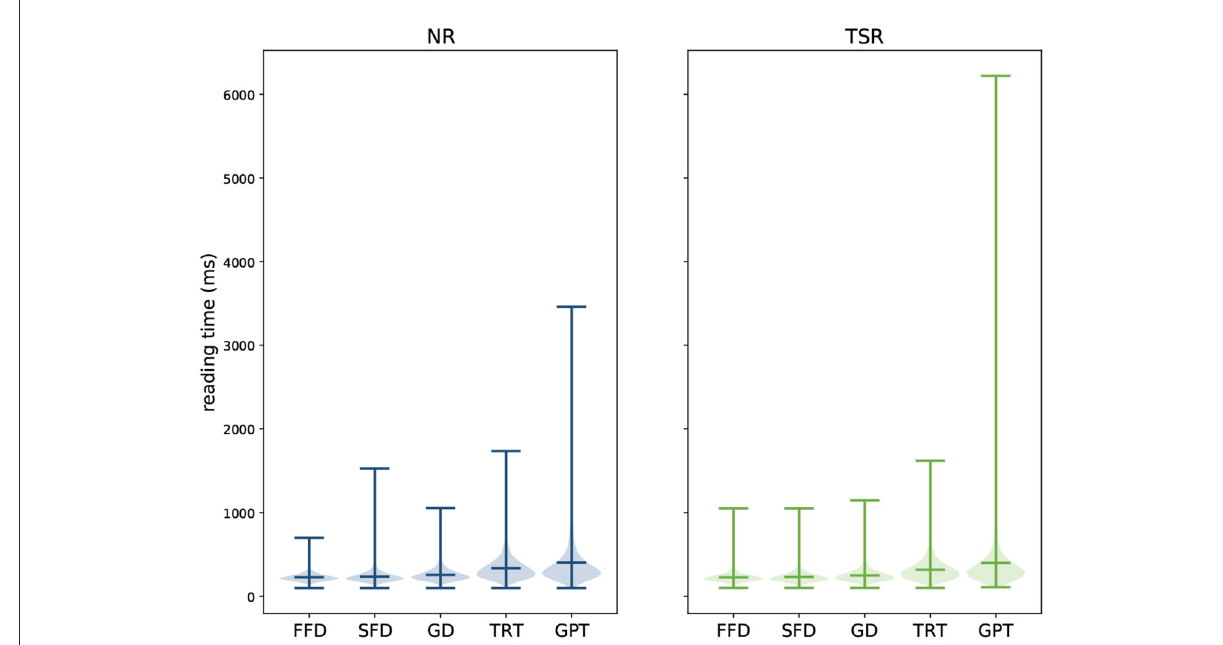
FIGURE2 Violin plots showing means, distributions, and ranges of the reading time measures per word for each task and each eye-tracking feature ( x -axis) in milliseconds.